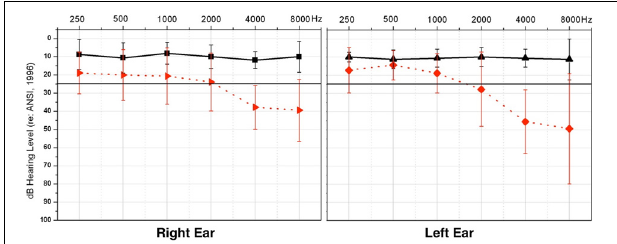
FIGURE 1 | Average pure tone thresholds across clinical test frequencies (X-axis) for right and left ears, respectively. Intensity of frequency presentation level is shown on the Y-axis. The normal hearing group (NH) thresholds are depicted in solid black, and the hearing loss (HL) group thresholds in dashed red. Vertical black bars indicate standard deviation. The solid black line illustrates the criterion for normal hearing, at 25dB